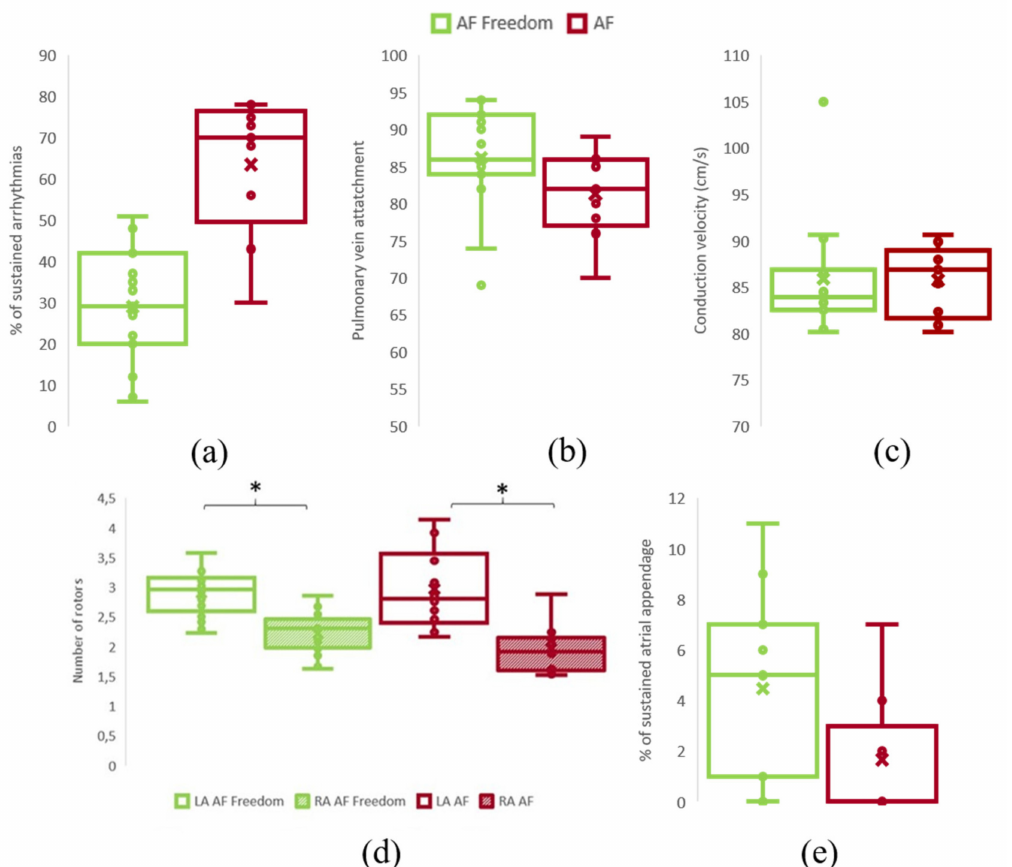
Figure 5. Simulation characterization. ( a ). Percentage of sustained F in both groups., ( b ). Percentage of simulations of rotors with pulmonary vein attachment in both groups. ( c ). Conduction velocity of simulated scenarios. ( d ). Number of rotors in the LA and RA for both groups. ( e ). Percentage of rotors with left atrial appendage attachment in both groups. * p <